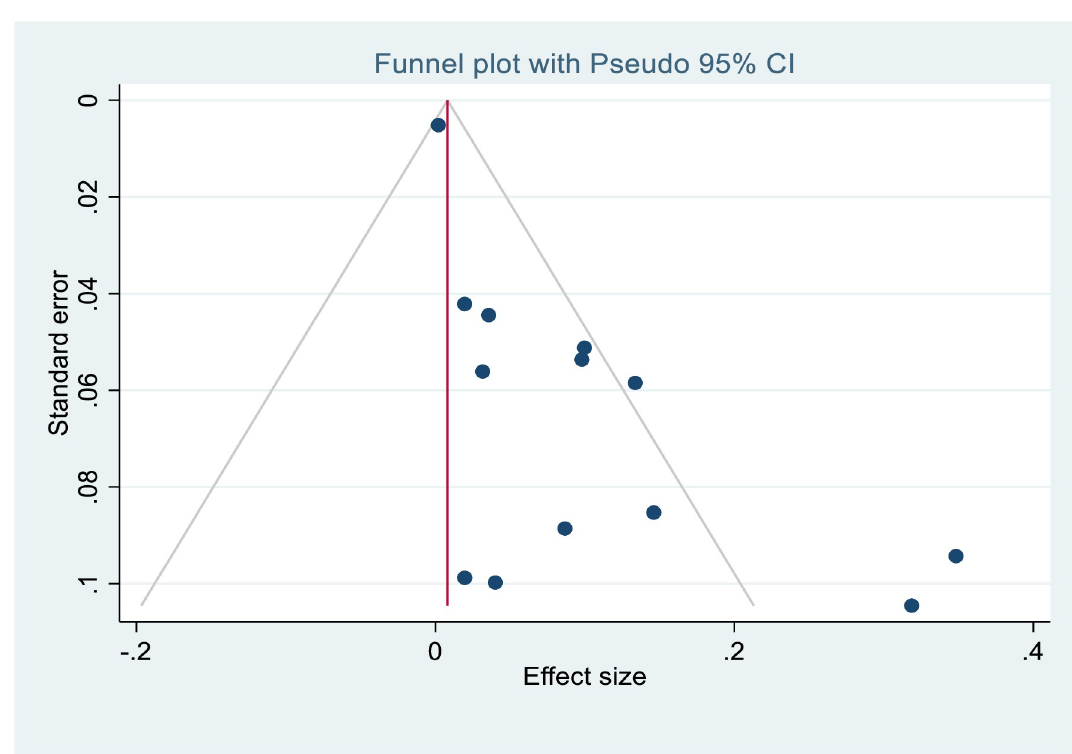
Fig 5. Funnel plot before Duval’s trim and fill analysis.